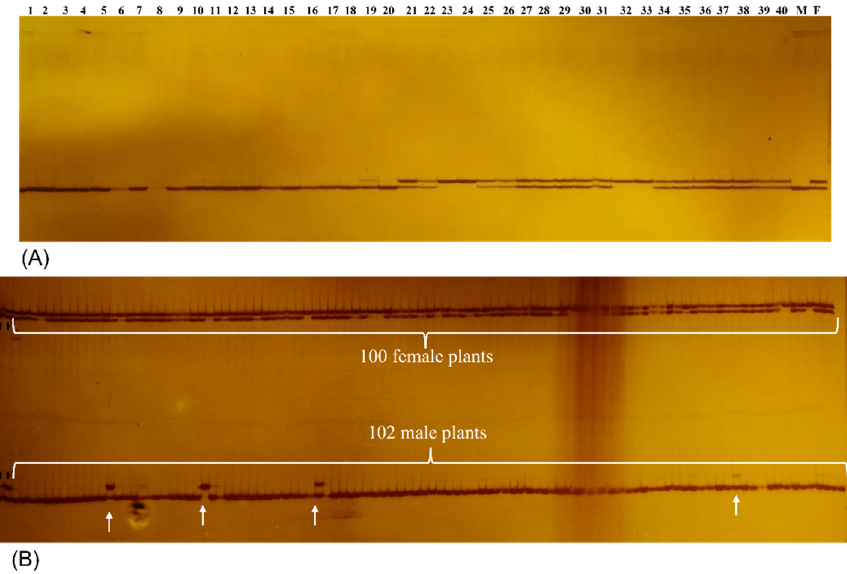
Figure 6. Electrophoresis-based visualization of PCR bands amplified with the EST-SSR primer pair PcSSR51. Lanes F and M denote female bulk and male bulk, respectively. ( A ) Lanes 1–20 and 21–40 represent the PCR products of male and female P. chinensis , respectively. ( B ) Lanes with white braces 1–102 indicate the PCR products of male P. chinensis ; lanes with white braces 1–100 represent the PCR products of female P. chinensis ; and white arrowheads denote the female-specific EST-SSR marker amplified with PcSSR55 primer pair.